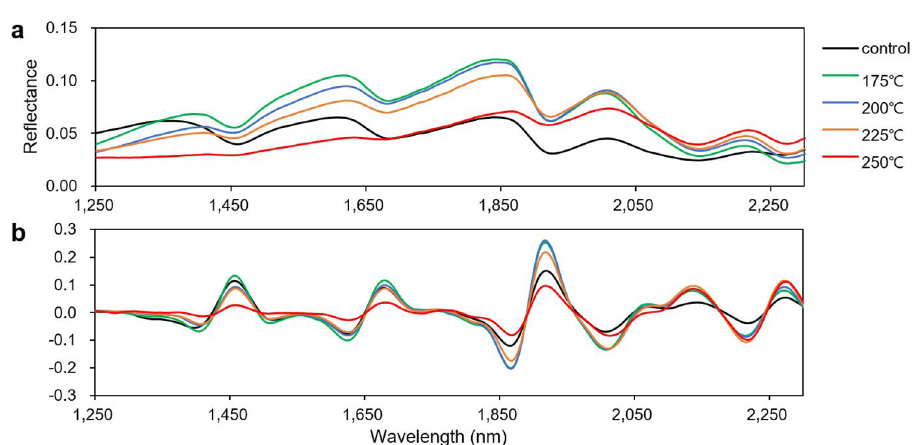
Figure 2. Original NIR spectra ( a ) and second-derivative spectra ( b ) with 1250–2300 nm region for hydrothermally carbonized kraft lignin and control